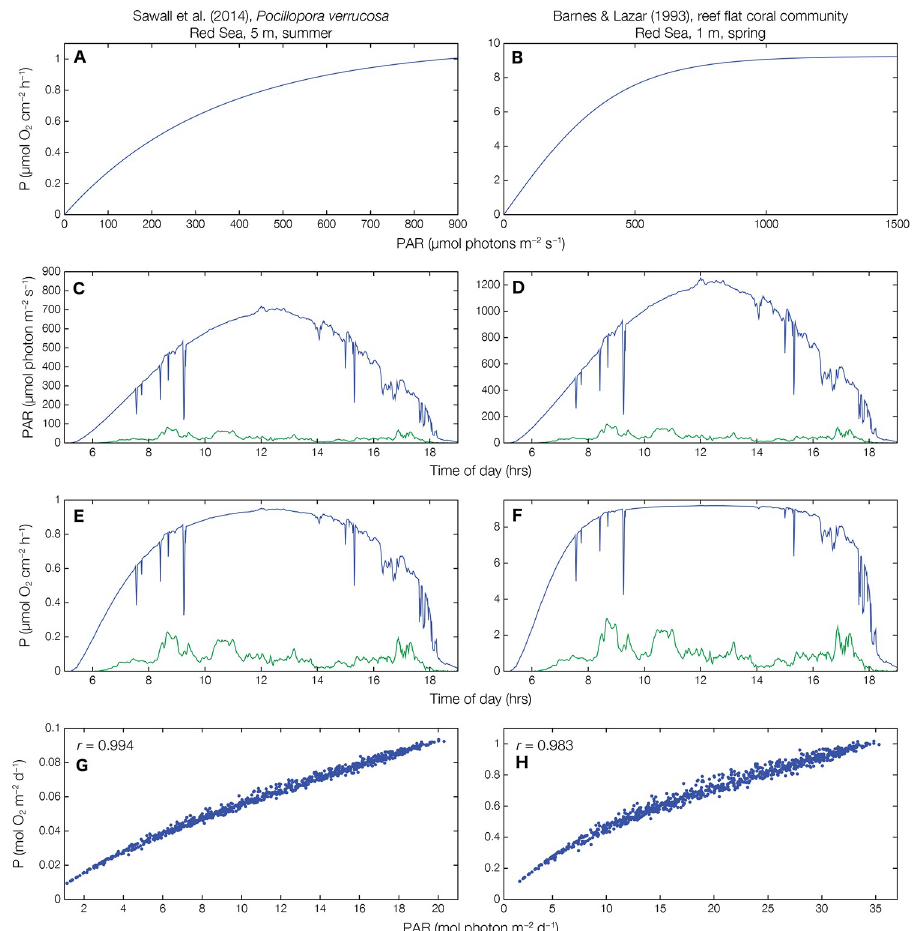
Fig 1. Results of the different steps of the model for a late saturating [15] and early saturating [2] instantaneous P-E curve. Instantaneous P-E curves reconstructed from the equations and parameters described in the respective publications (see specifics in Table 1) ( A, B ). Maximum (green line) and minimum (green line) instantaneous PAR of the Bermuda light curves adjusted to local maximum PAR of published P-E curve ( C, D ). Derived instantaneous P corresponding to adjusted PAR at different times of day and under different cloud cover scenarios ( E, F ). Time- integrated P-E curves representing daily rates of P and daily PAR for 928 different days with different cloud cover scenarios ( G, H ).